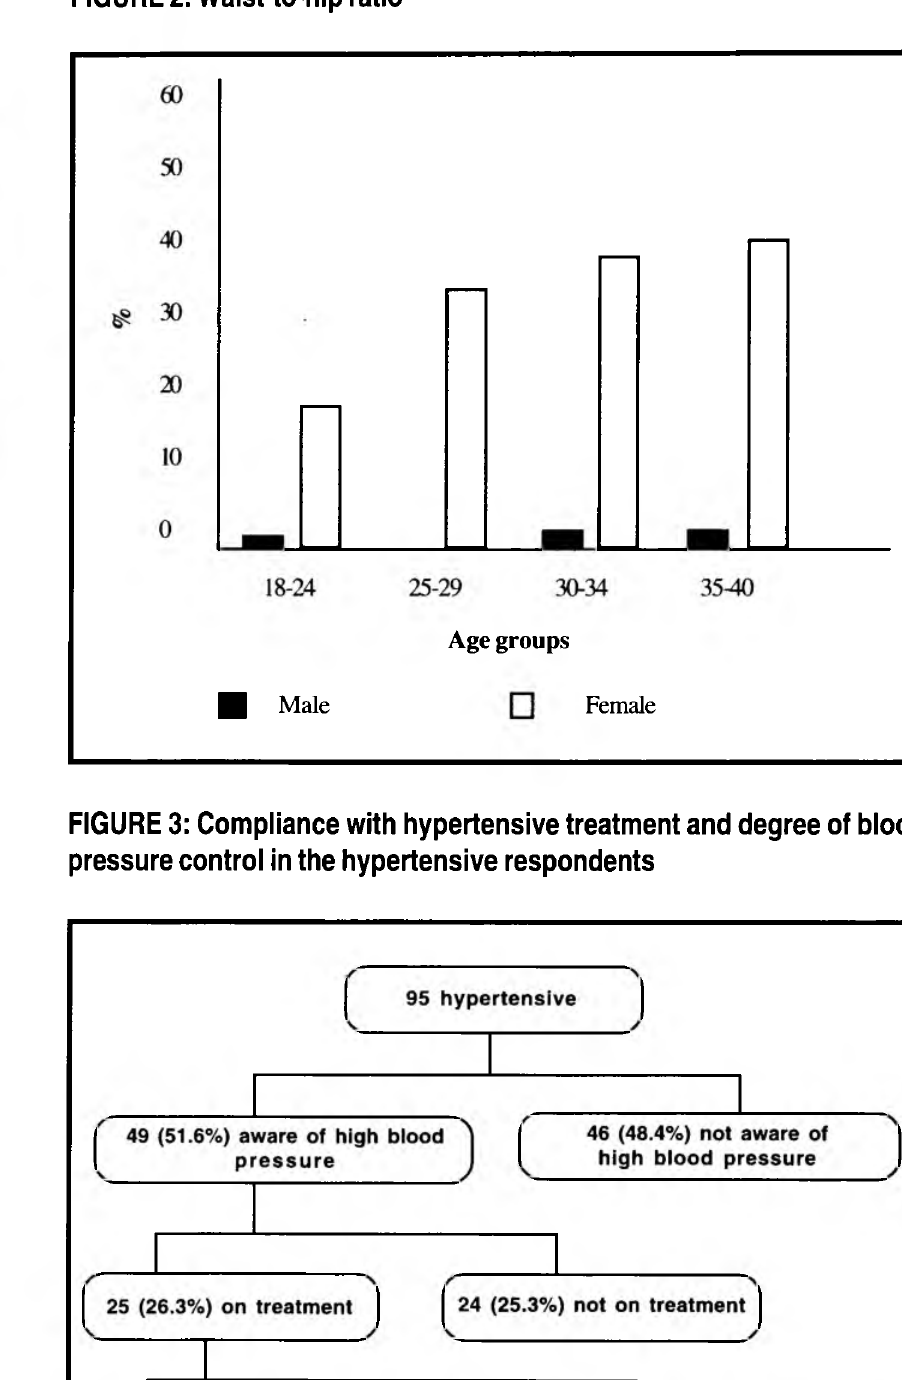
FIGURE 2: Waist-to-hip ratio